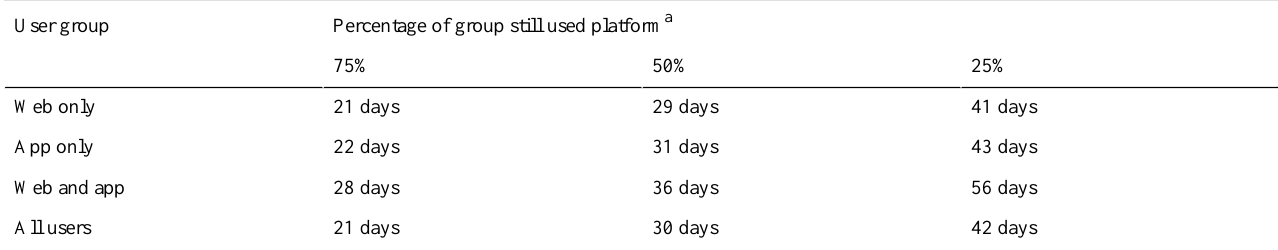
Table 4. Survival time by group in the subsample of users who were 10,000 Steps members for at least 3 months (n=11,651).